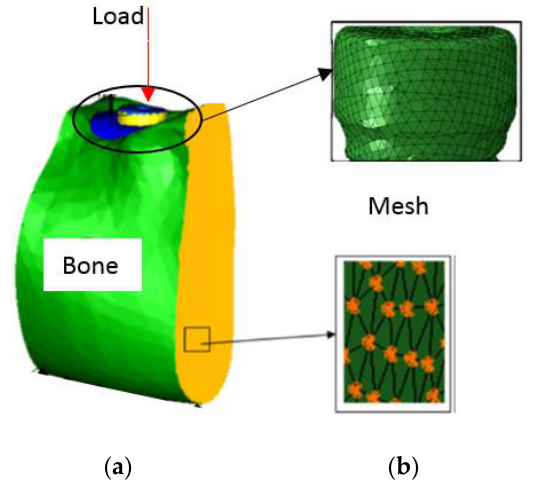
Figure 2. Three-dimensional model. ( a ) Bone and dental implant assembly; ( b ) Mesh.